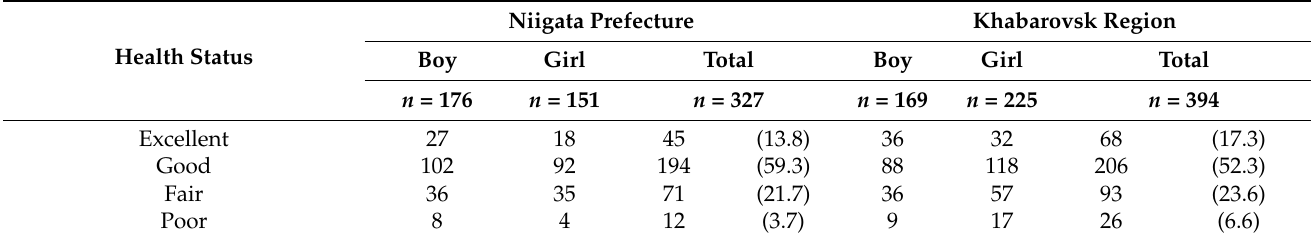
Table 2. Health status at the time of the survey, n = 721.